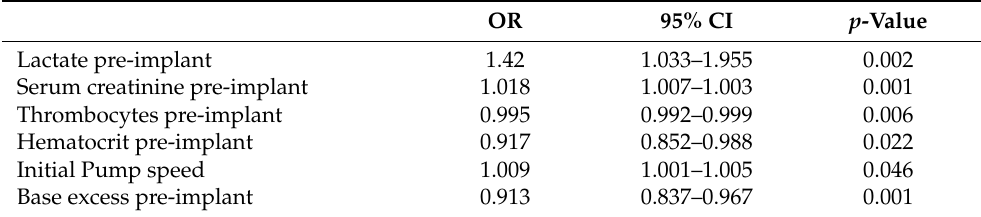
Table 3. Predictors of AKI 2/3 in patients undergoing ECMO implantation.